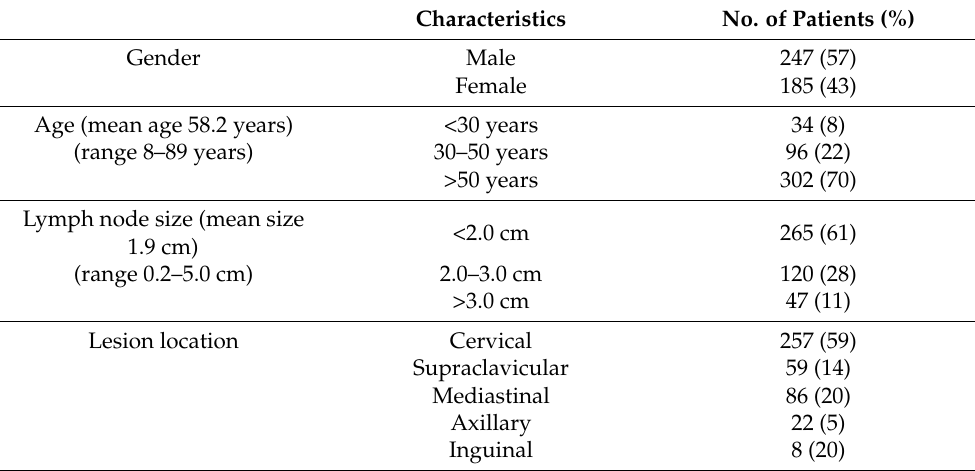
Table 1. Clinical characteristics of 432 patients with lymphadenopathy.